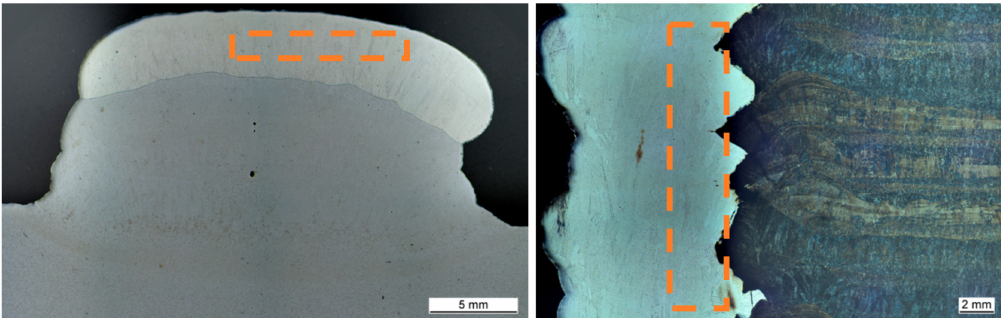
Figure 11. Microsection of the additive corrosion protection layers (box: derived specimen